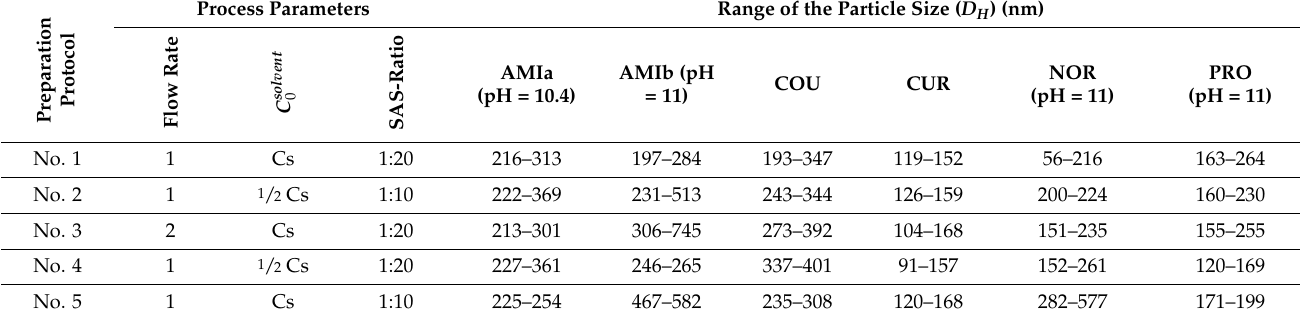
Table 2. The parameters of the preparation protocols, such as the flow rate (mL/min), the compound concentration in the solvent solution ( C solvent ) and the solvent:antisolvent ratio (SAS-ratio) together 0 with the range of the particle size ( D H ) are given. If the antisolvent is other than distilled water, its pH is